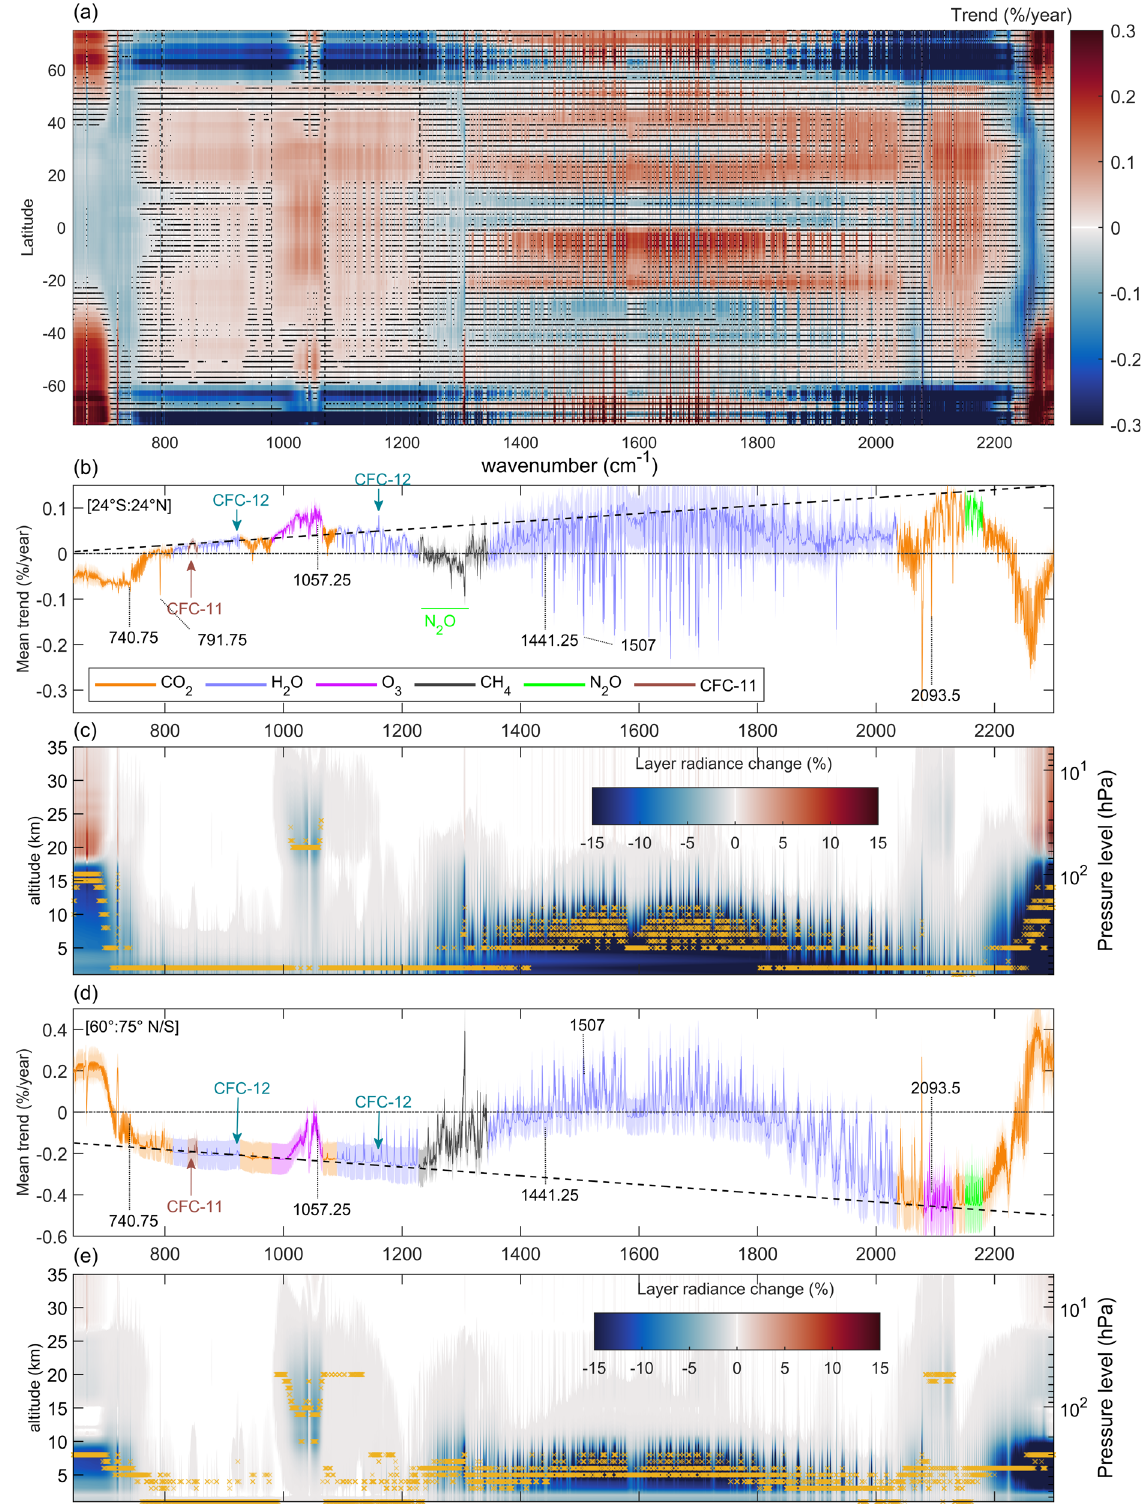
Fig. 1 Linear trends in the SOLR for all IASI channels between 645 and 2300 cm − 1 . a 2° zonal mean SOLR linear trends from 10 years (2008 – 2017) of IASI-derived clear-sky SOLR (percentage per year). Dots indicate trends non-statistically signi fi cantly different from zero at the 95% con fi dence level. b Area-weighted global mean trends for the tropical region (24°S – 24°N) with their 95% con fi dence limits (shaded area). The straight dotted line illustrates the quasi-linear increase of the relative change in radiation fl ux with wavenumber in response to a surface temperature increase. c Radiance changes (%) as a function of altitude for a tropical standard atmosphere. The orange crosses show the altitude of the peak of sensitivity. d Same as panel b , but for high-latitude regions (60° – 75°N and S). e Same as panel c but for a subarctic standard